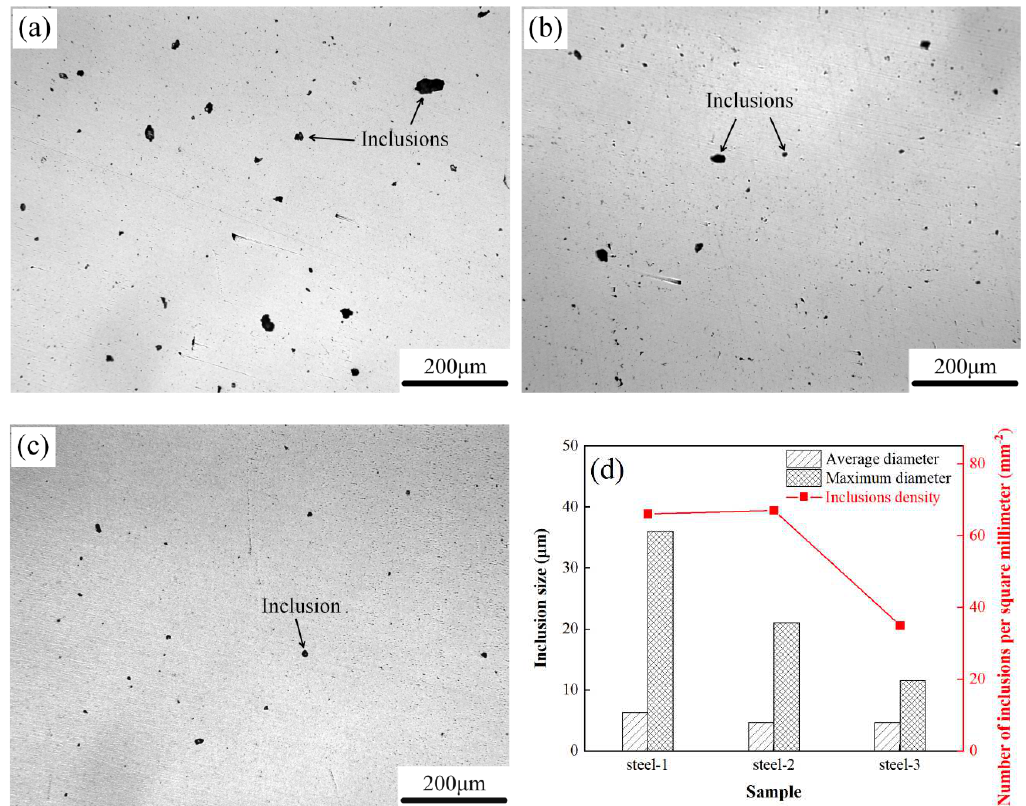
Figure 1. Morphology ( a – c ) and size ( d ) of inclusions in three ferritic stainless steels: ( a ) steel-1, ( b ) steel-2, and ( c )